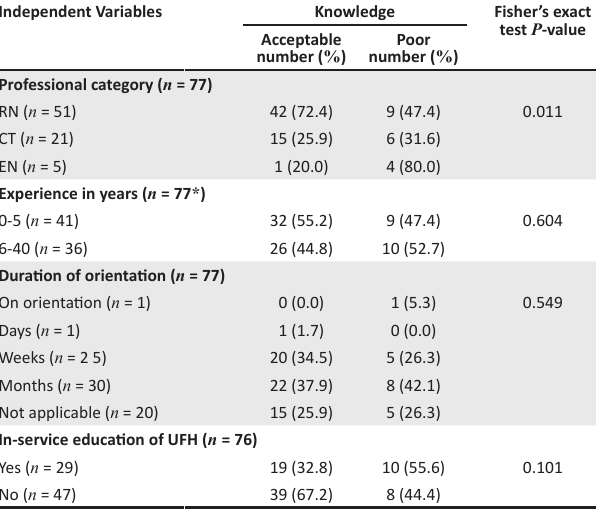
TABLE 4: Association between knowledge and selected independent variables. Independent Variables